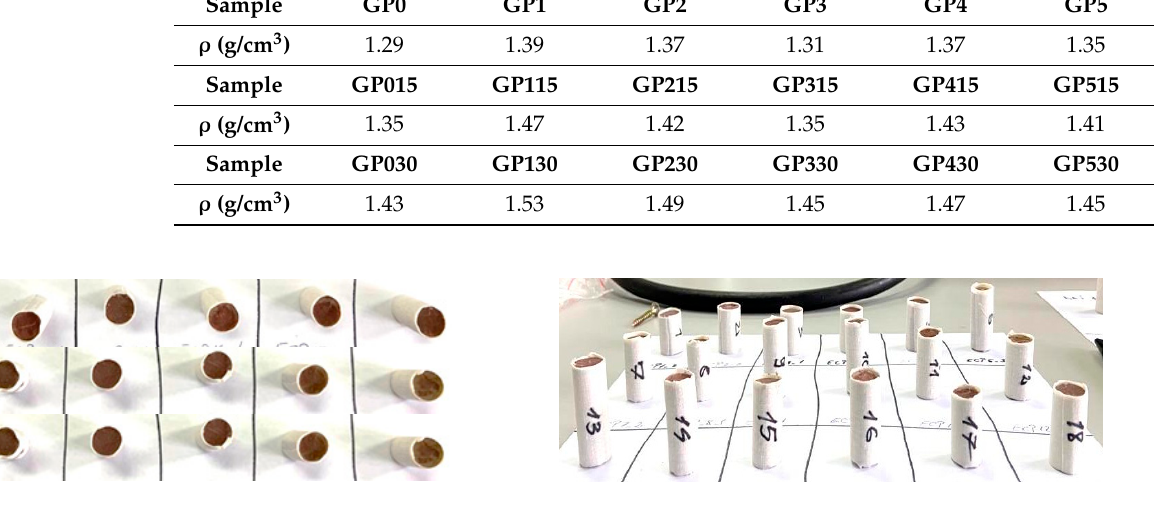
Figure 8. Cylindrical grain propellant molds. Table 5. Loading density values for the developed formulations.